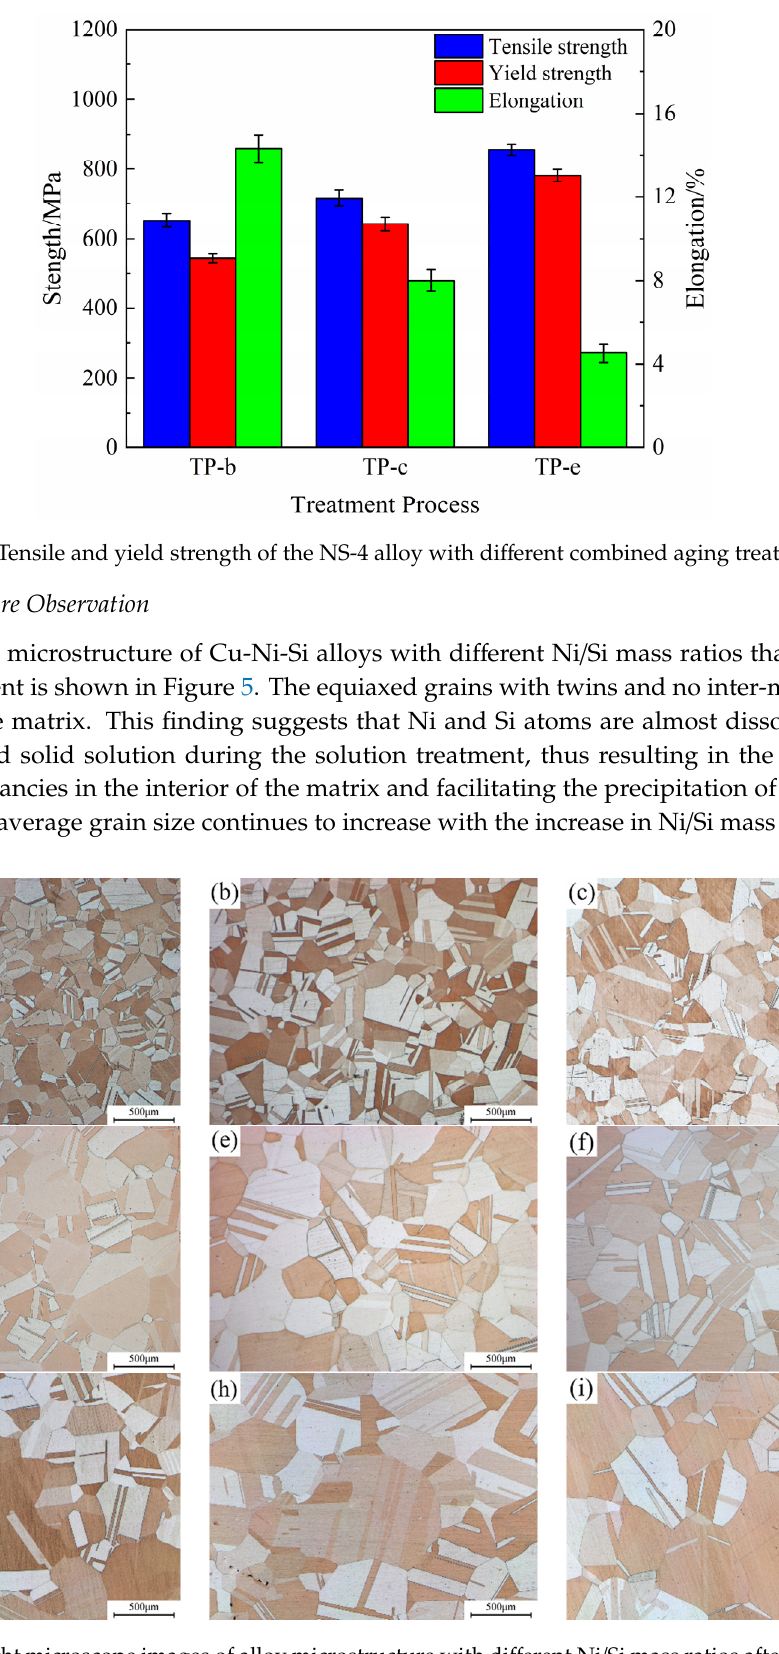
Figure 5. Light microscope images of alloy microstructure with different Ni/Si mass ratios after solution treatment; ( a – i ) NS ‐ 1–NS ‐ 9.